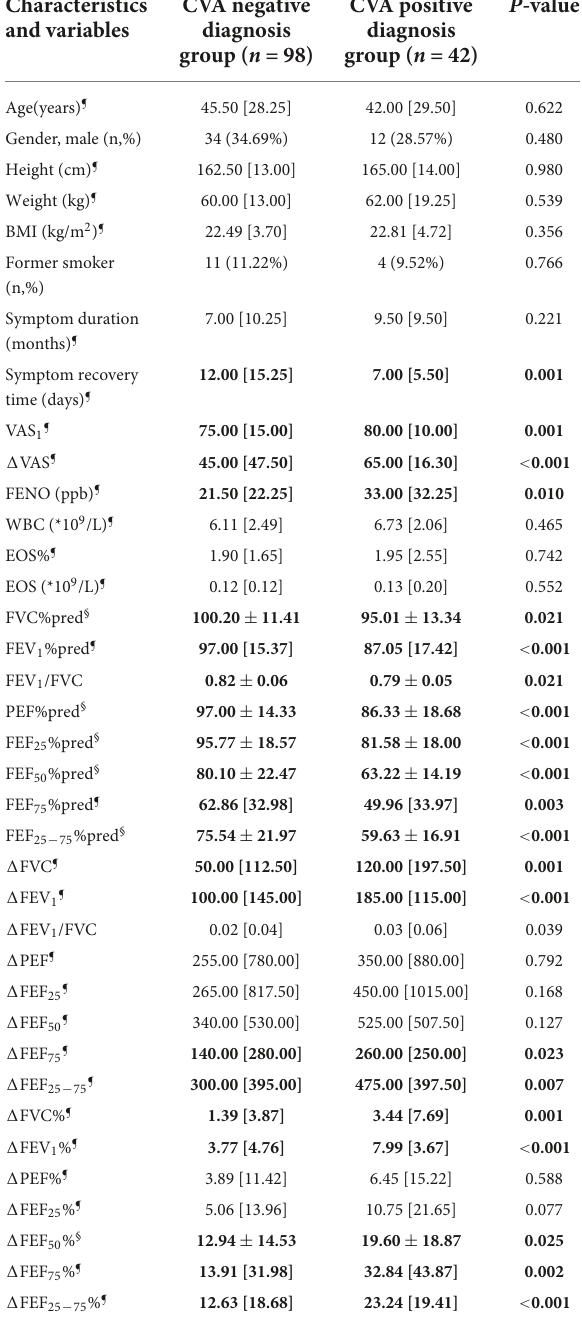
TABLE 1 Demographic data and clinical features of participants in the CVA negative diagnosis group and CVA positive diagnosis group. Characteristics and